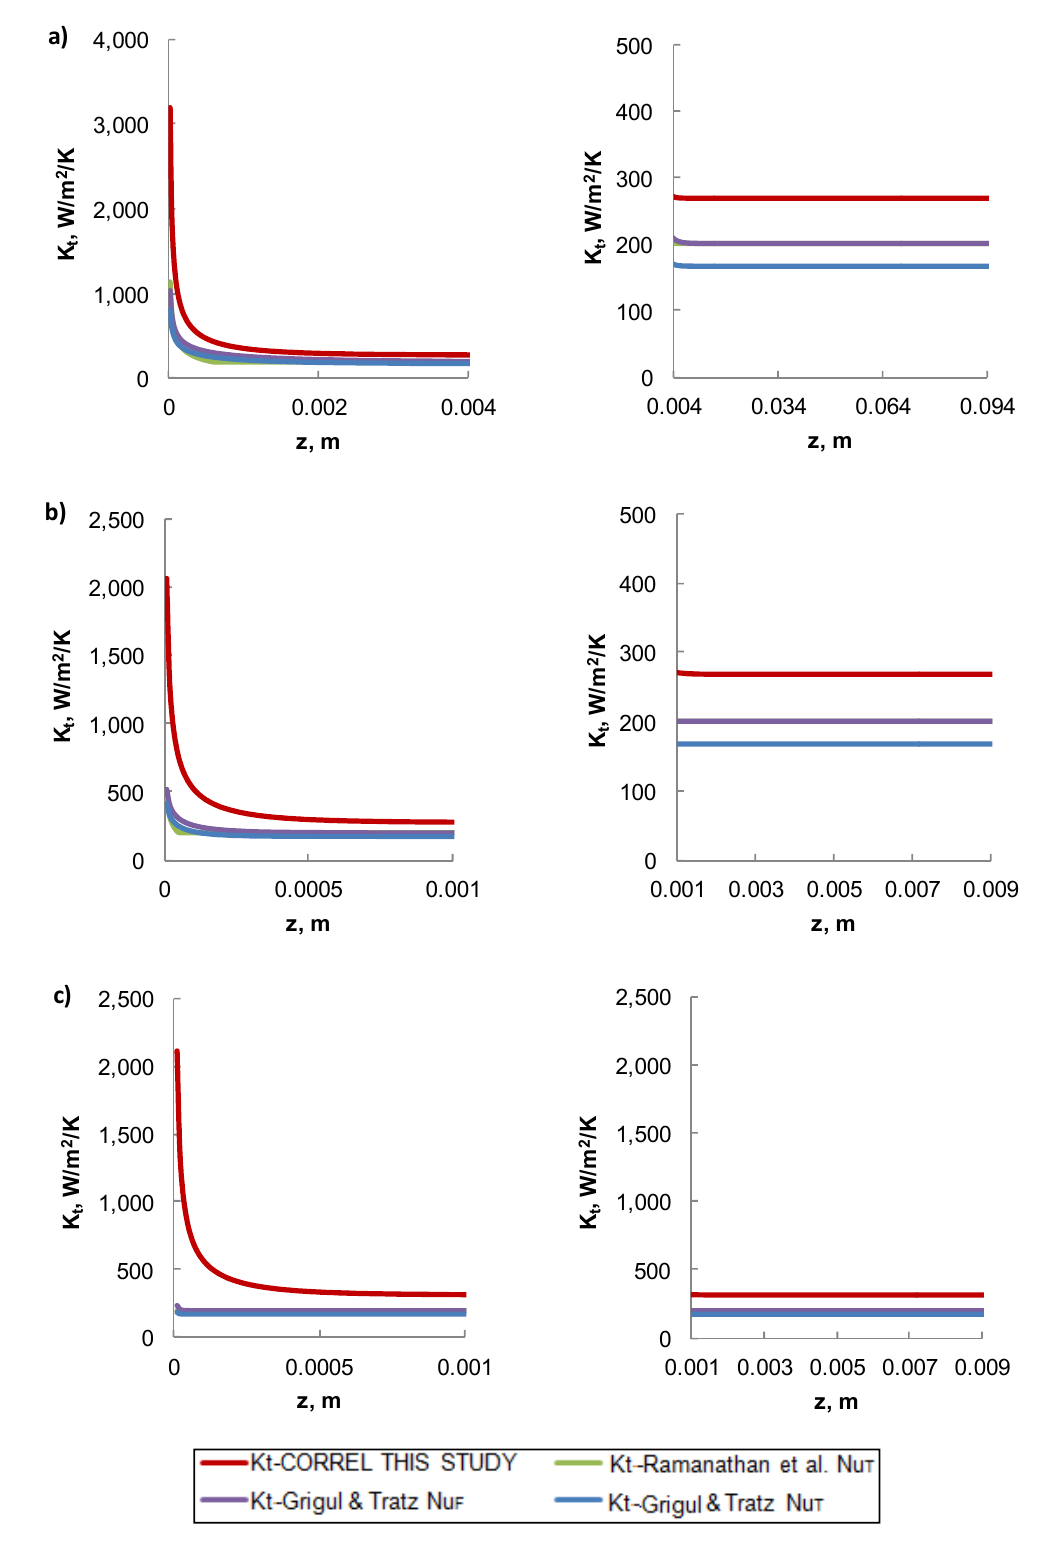
Figure 9. Comparison of the heat transfer correlation for monoliths published in the literature by Ramanathan et al. [12] and Grigul and Tratz [22] with the one proposed in this paper. Diagrams of heat transfer coe ffi cient along the cell length at temperature 400 ◦ C. Cell diameter d = 1.1 mm. ( a ) Velocity u = 6.27. Re = 109, ( b ) Velocity u = 0.521. Re = 9, ( c ) Velocity u = 0.033. Re =